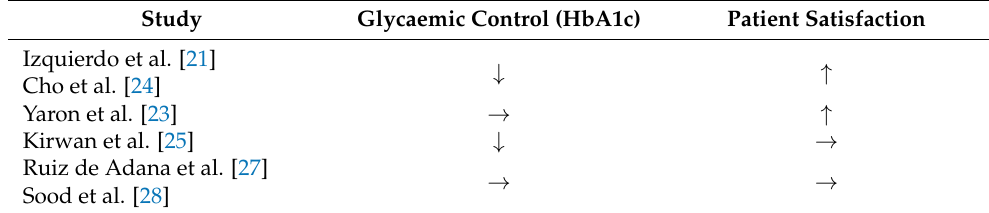
Table 2. The relationship between patient satisfaction and glycaemic control.